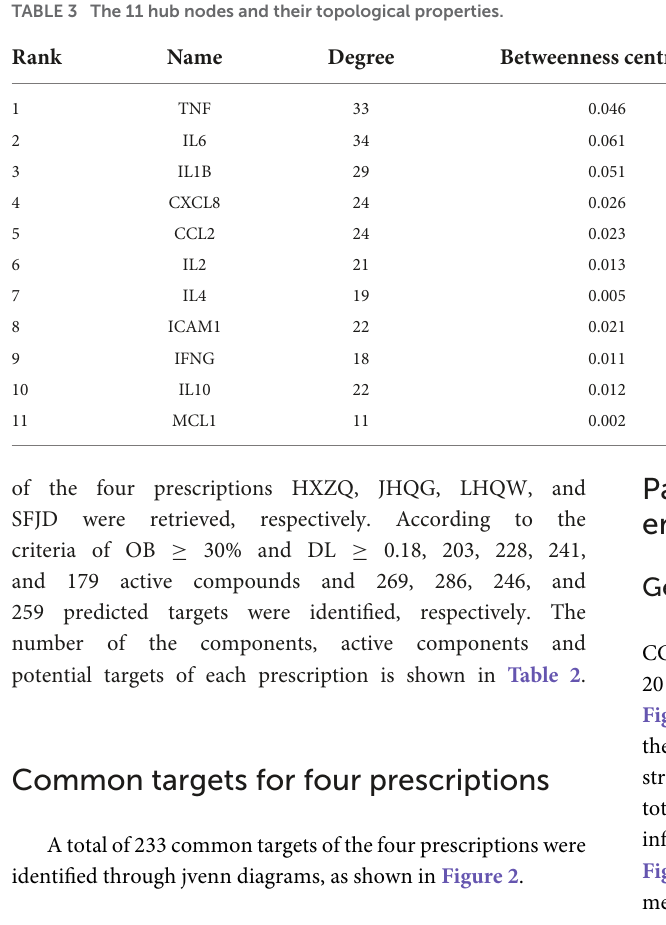
TABLE 3 The 11 hub nodes and their topological properties.